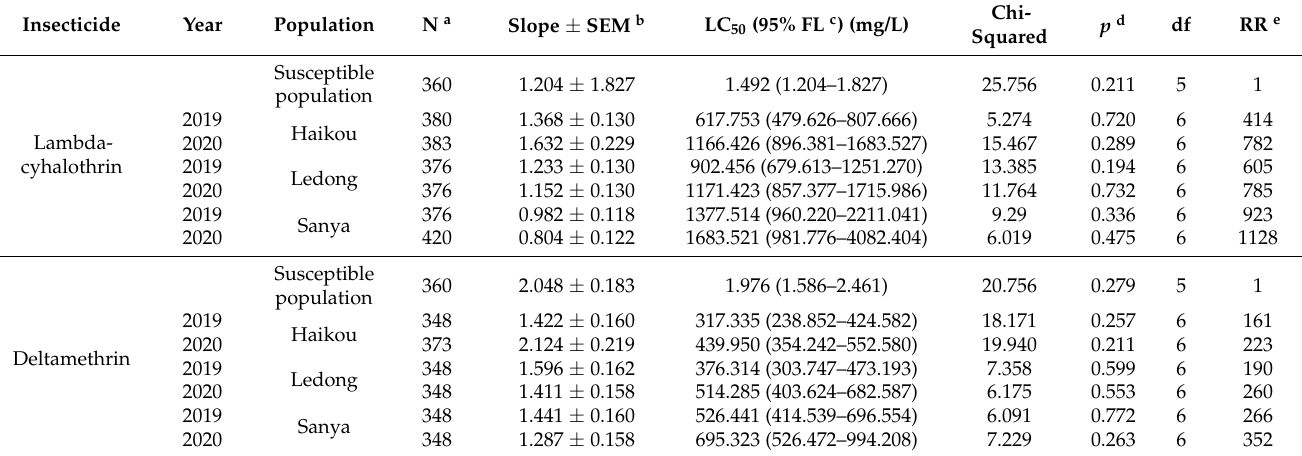
a Number of thrips tested. b Standard error. c Fiducial limit. d p values are based on Chi-square goodness of fit test. p values > 0.05 suggest goodness of fit of the model. e RR (Resistance ratio) = LC 50 of field population/LC 50 of susceptible